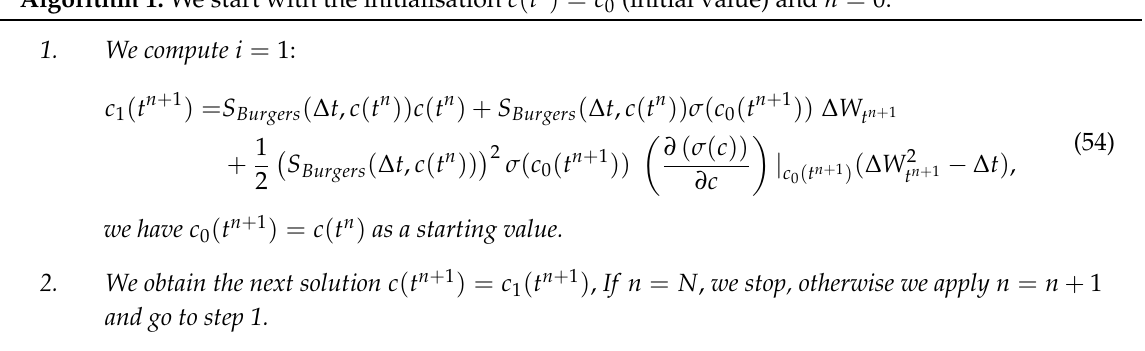
Algorithm 1: We start with the initialisation c ( t 0 ) = c 0 (initial value) and n =